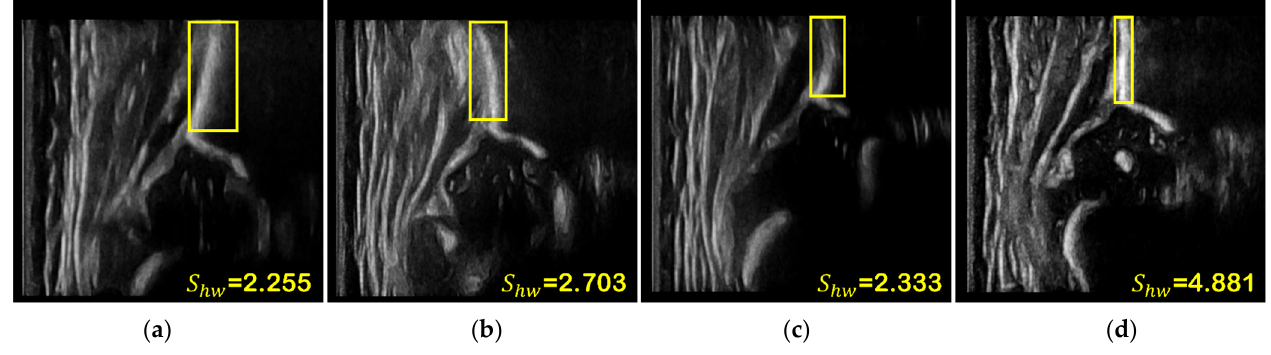
Figure 5. The effect of different ilium shapes on the height–width ratio of the bounding box. The ilium in ( a , b ) are inclined leftward and rightward, respectively. The ilium is curved in ( c ). The ilium is straight and vertical in ( d ), with the highest value for S hw